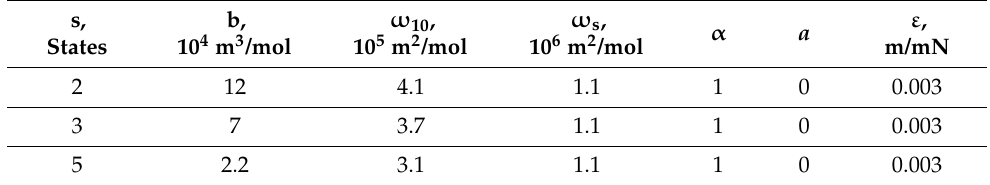
Table 2. Parameters of the isotherms of C 14 EO 8 solutions assuming 2, 3, 5, and 10 states of the mul ‐ tistate adsorption Model R.